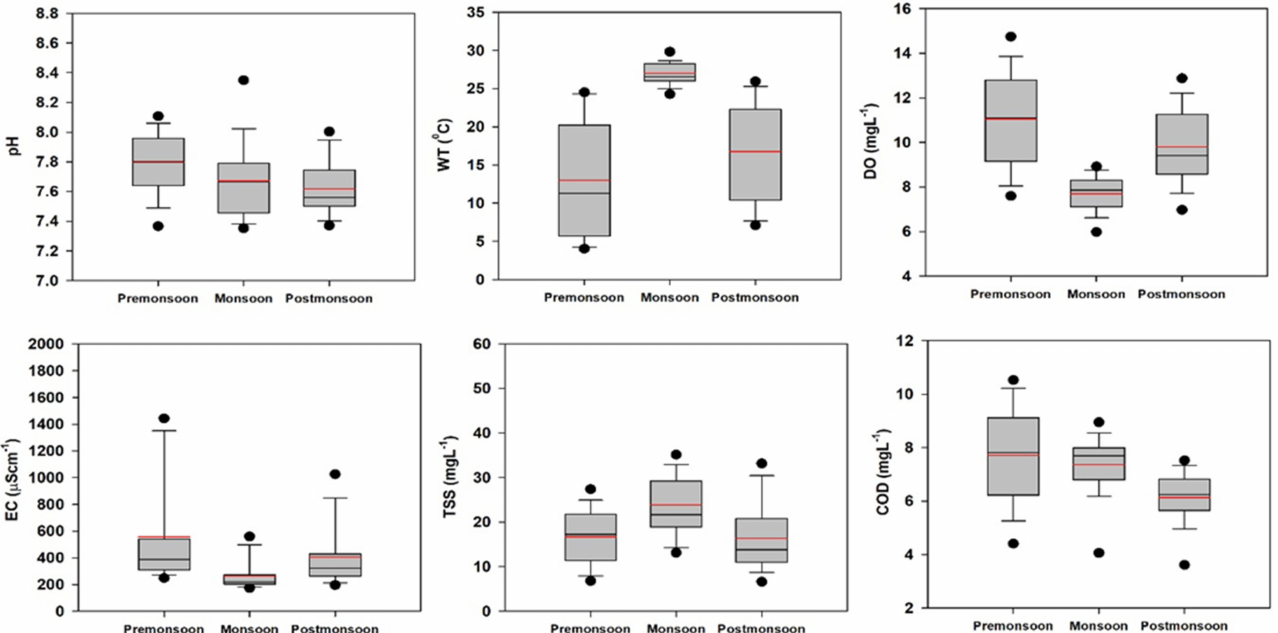
Figure 8. Temporal variations in pH, WT, DO, EC, TSS, and COD in the Yeongsan River (pH: hydrogen ion concentration; WT: water temperature; DO: dissolved oxygen; EC: electrical conductivity; TSS: total suspended solids; COD: chemical oxygen demand; premonsoon: January–June; monsoon: July–August; postmonsoon: